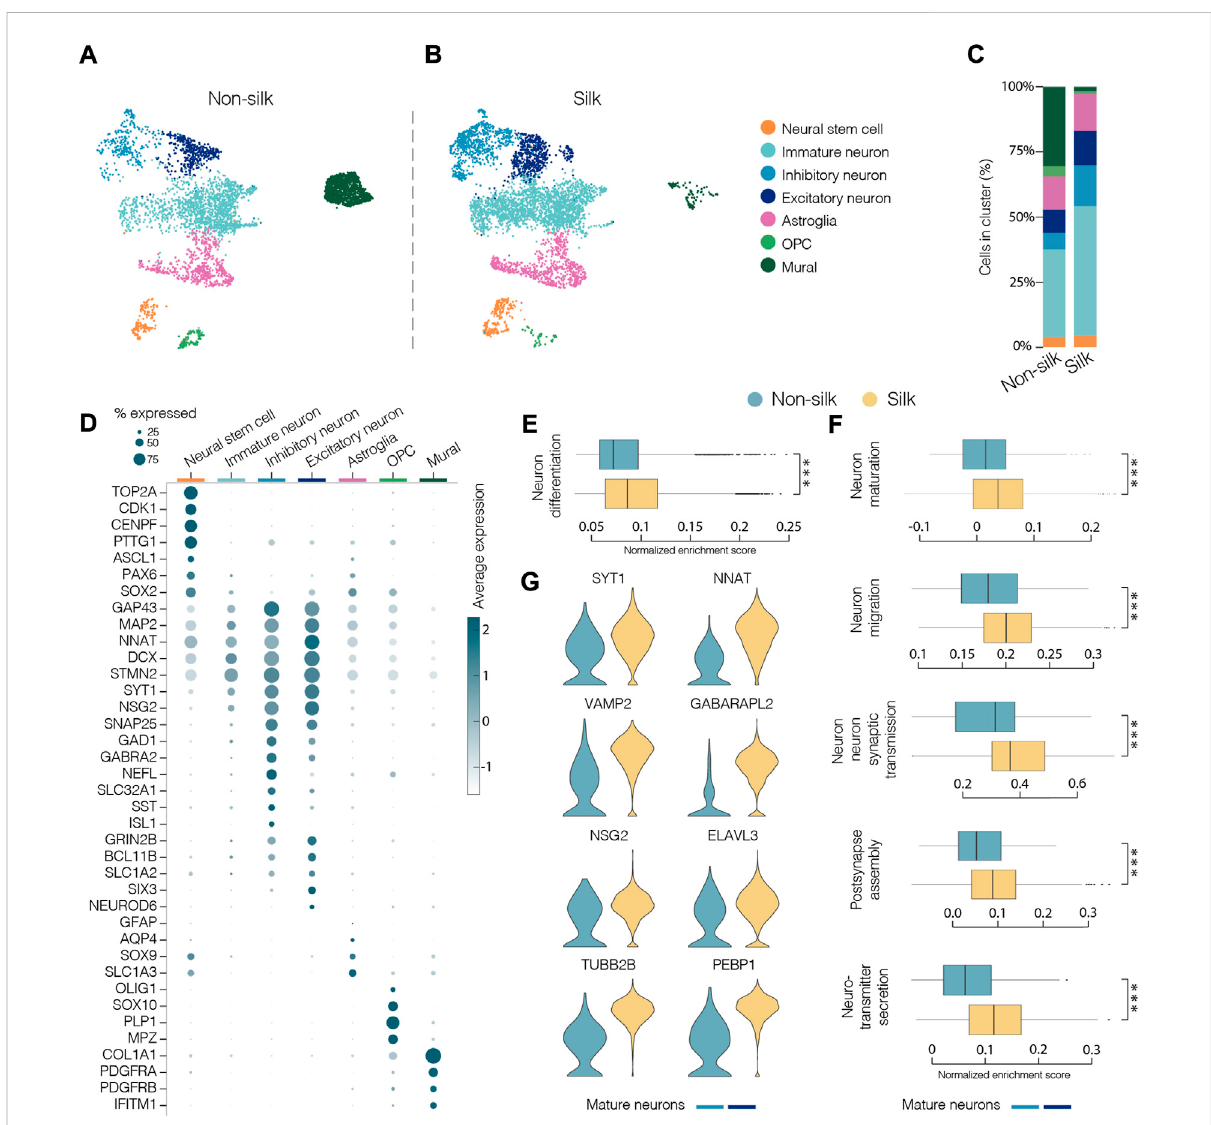
FIGURE 4 Single-cell transcriptomics reveals mature neuronal features in silk cerebral organoids. (A and B) 2D scatter plot of uniform manifold approximation and projection (UMAP) embeddings of non-silk H) and silk I) organoids at day 120 each showing clustering of ~4,500 randomly selected cells. Colors indicate different cell type assignments. OPC, oligodendrocyte progenitor cells. (C) Bar plot showing the percentage of cells belonging to each cluster from silk and non-silk organoids. (D) Dot plot showing expression levels of indicated genes in each cluster. Indicated genes are established markers for neural stem cells, inhibitory and excitatory neuronal subtypes, astroglia, OPC, and mural cells. (E) Gene set enrichmentanalysis(GSEA)showingastatisticallysigni fi cantdifferentscorein Neurondifferentiation terminnon-silkandsilkbrainorganoids.*** p < 0.001, two-tailed Wilcoxon rank sum test. (F) GSEA of Neuron maturation, Neuron migration, Synaptic transmission, Post-synapse assembly and Neurotransmitter secretion terms in mature neuronal clusters. *** p < 0.001, two-tailed Wilcoxon rank sum test. (G) Expression of representative mature neuronal markers in non-silk and silk brain organoid neuronal clusters after 4 months in